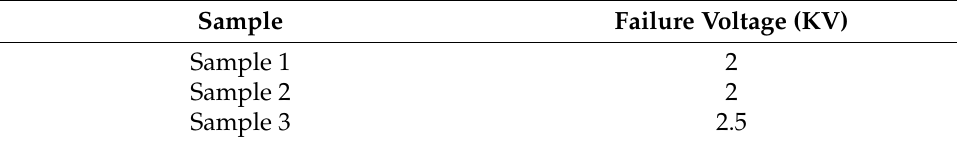
Table 3. HBM test results of a test chip with drain contact